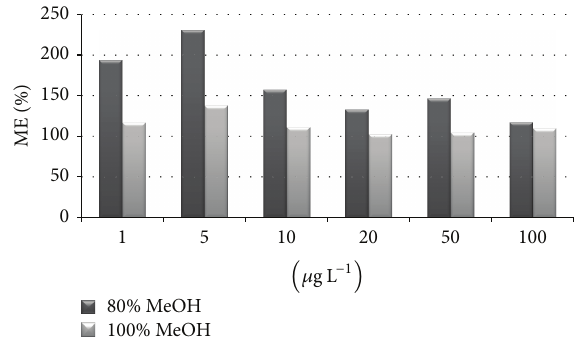
Figure 4: A quantitative estimation of matrix effect for the determi- nationofDAinmusseltissueusingtwodifferentextractionsolvents, methanol/water 80 : 20 and methanol.